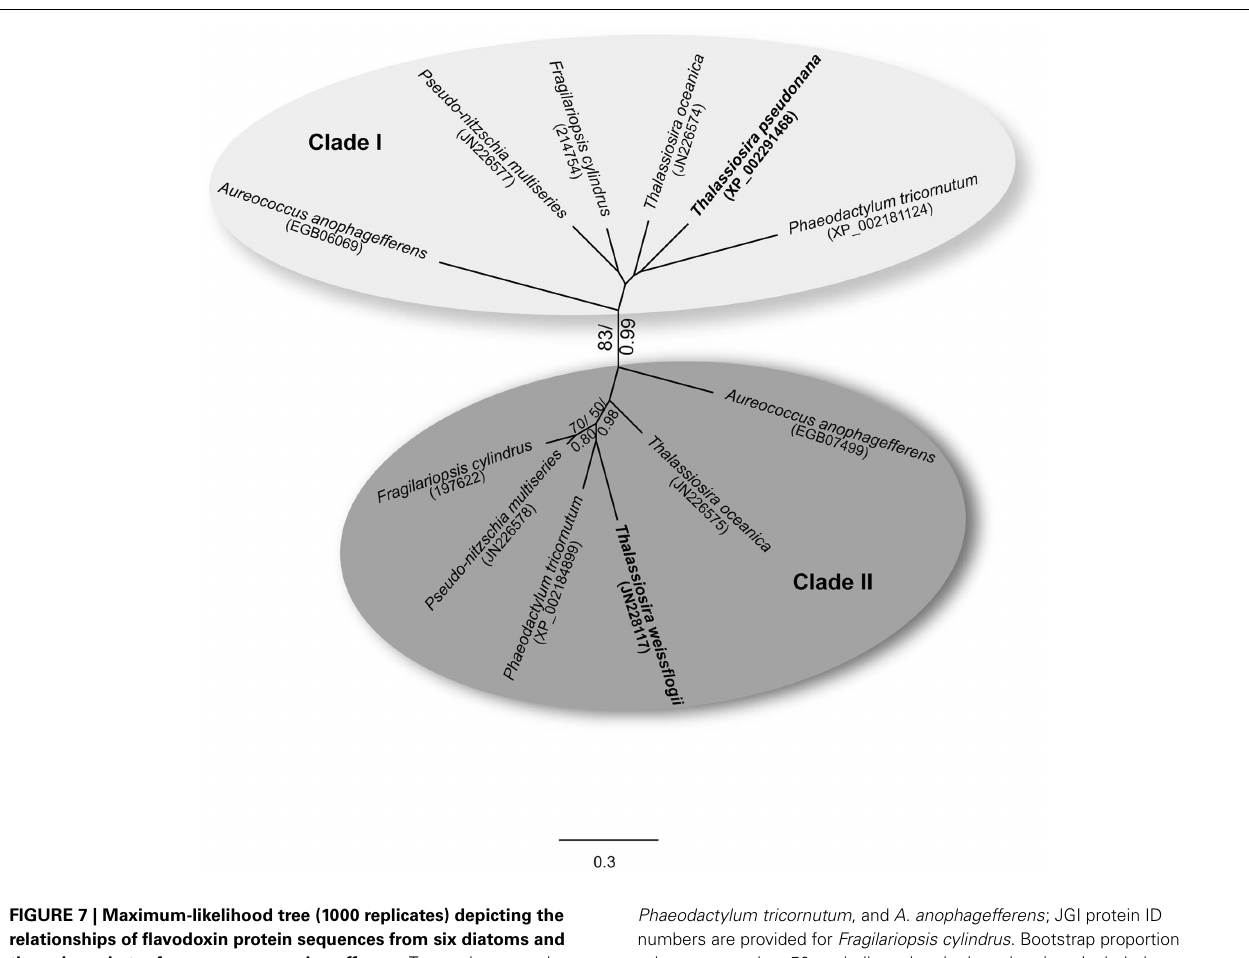
FIGURE 7 | Maximum-likelihood tree (1000 replicates) depicting the relationships of flavodoxin protein sequences from six diatoms and the pelagophyte, Aureococcus anophagefferens . T. pseudonana and T. weissflogii are highlighted in bold; clades I and II are indicated. GenBank accession numbers are shown in parentheses for T. pseudonana , T. weissflogii , T. oceanica , Pseudo-nitzschia multiseries ,